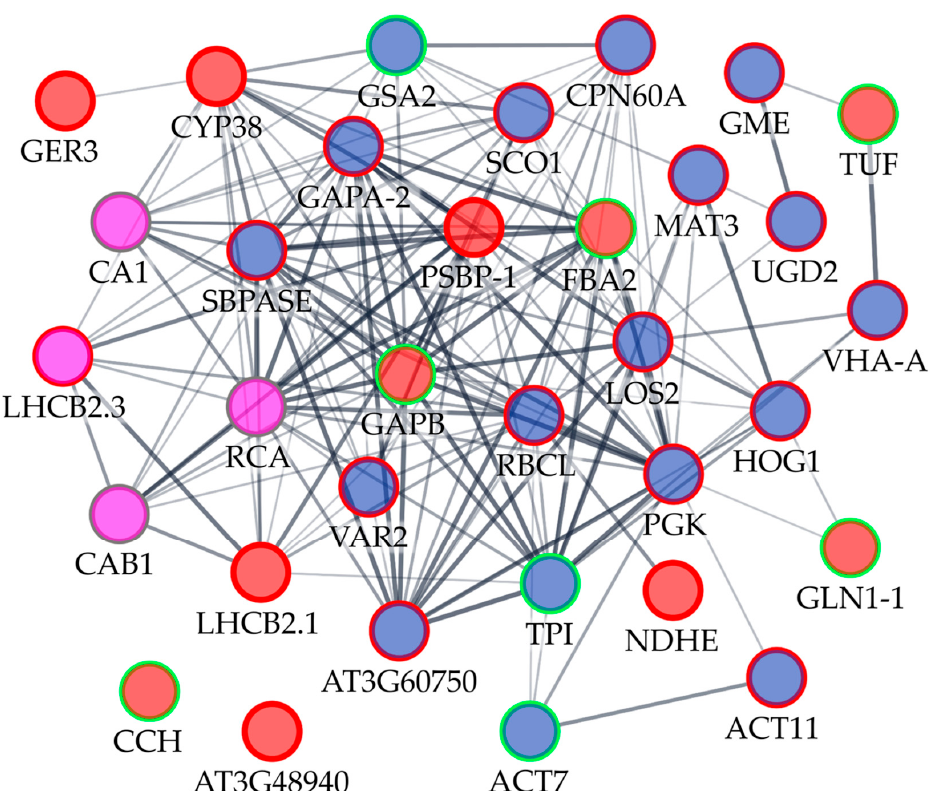
Figure 2. A functional interaction network of tobacco in vitro shoot proteins responsive to culture senescence or timentin treatment. The network was built using the String database using Arabidopsis homologs related to the identified tobacco proteins. Node base color represents proteins differentially expressed between the early and late phase (corresponding to one and three weeks of cultivation, respectively) of the shoot propagation cycle (red), proteins with carbonylation content changes in timentin-treated shoot samples compared to control (blue), or proteins responsive to both factors (magenta). The color of the node border represents a decrease (green), increase (red), or contrasting response (grey) of protein abundance or carbonylation content compared to the control. The thickness of the connecting lines represents the significance of the interaction. Two nodes that lack significant interactions within the network are shown at the bottom.